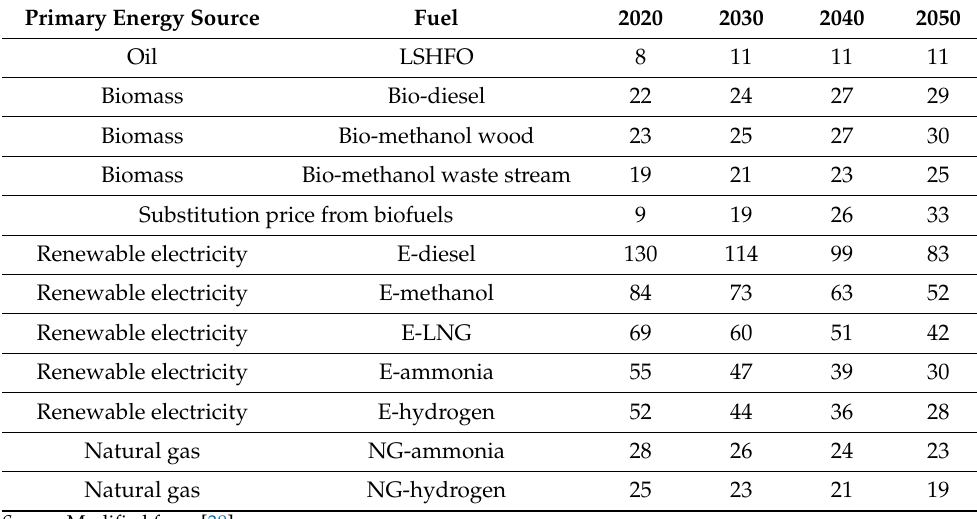
Table 2. Marine fuel price predictions from Lloyds Register and UMAS (2020) in USD/GJ. Primary Energy Source